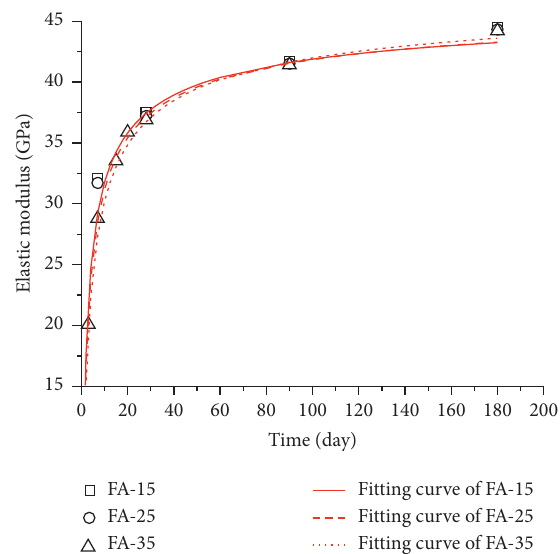
Figure 7: Measured elastic modulus and calculated development by means of equation (4).